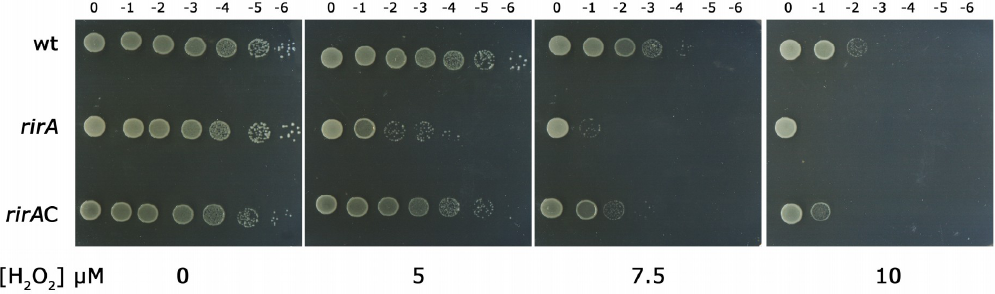
Figure 2. Growth of S. fredii wild-type strain SVQ269 (wt), rirA mutant SVQ780 ( rirA ) and complemented strain SVQ780C ( rirA C) on TY in the absence or presence of different concentrations of H 2 O 2 . Tenfold serial dilutions of bacterial cultures (10 9 cells/mL) are marked above each column. A representative example of at least two experiments is shown.